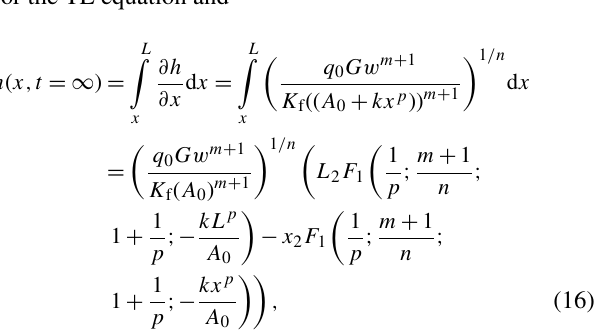
Figure 2. Steady-state depositional profile obtained by solving both the ξ – q and TL equations using K f = 10 − 5 m 1–2m yr − 1 ; G = 1yrm − 1 ; K d = 10 − 5 m − 2m yr − 1 ; w = 10 4 m; m = 0 . 4, n = 1, L = 100km; A 0 = 10 8 m 2 ; k = 0 . 6; p = 2 and q 0 = 10myr − 1